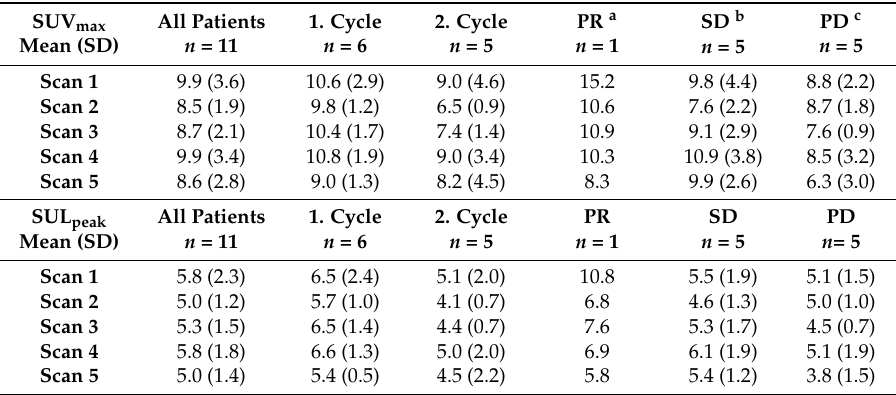
Table 3. FDG-uptake in tumor during